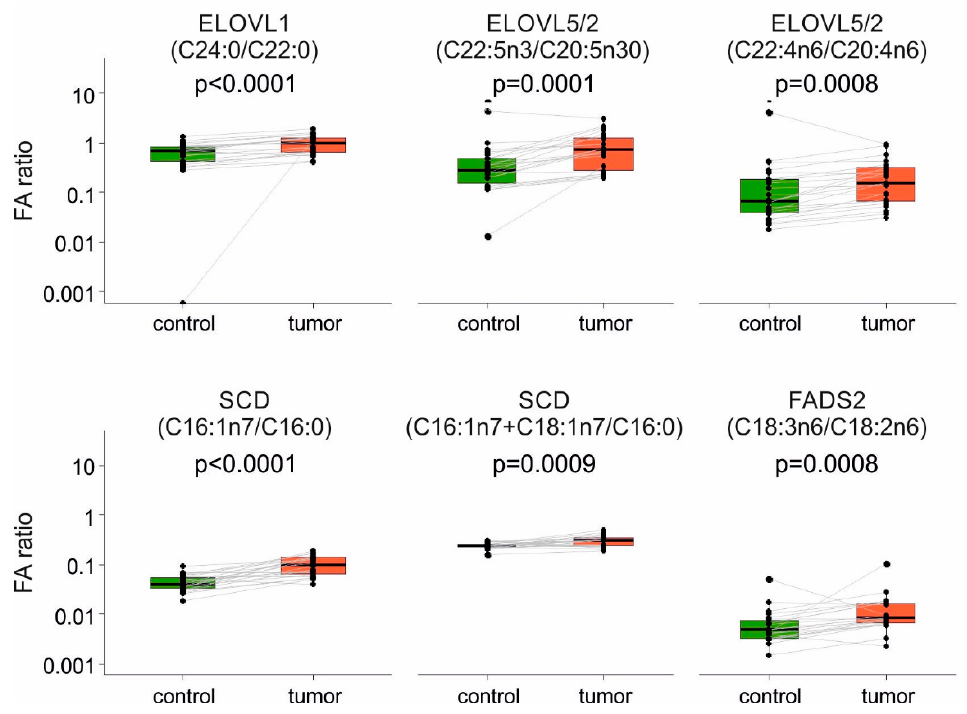
Figure 2. Calculated activities of enzymes involved in fatty acid (FA) synthesis, based on the amounts of individual fatty acids (product-to-precursor ratios) determined in purified non-tumor (control) and tumor EpCAM + cells (n = 22). Values of non-tumor and corresponding tumor cells from the same patients are linked in pairwise graphs and the respective p -values are indicated above each pair of box plots. The identities of FAs used for calculations are indicated above each pair of box plots.